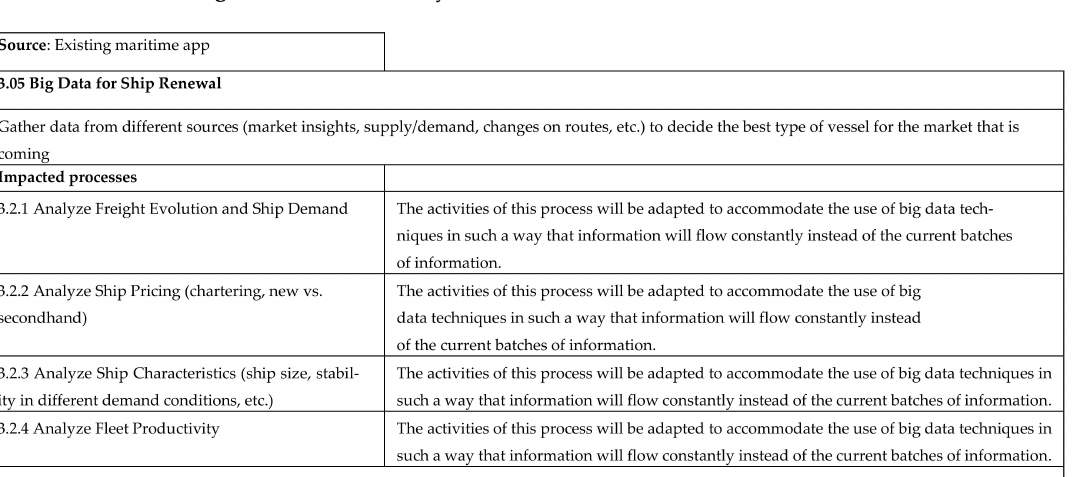
Figure A30. ISPS security levels data sheet.